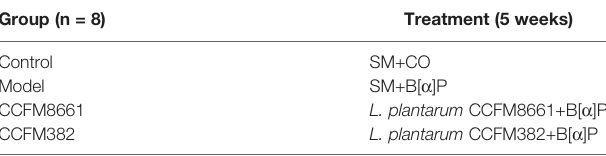
TABLE 1 | Animal experimental